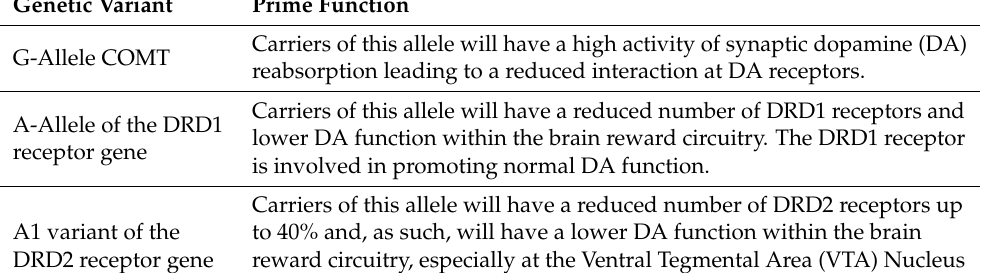
Table 2. Summary GARS test allele function and behavioral risk predisposition